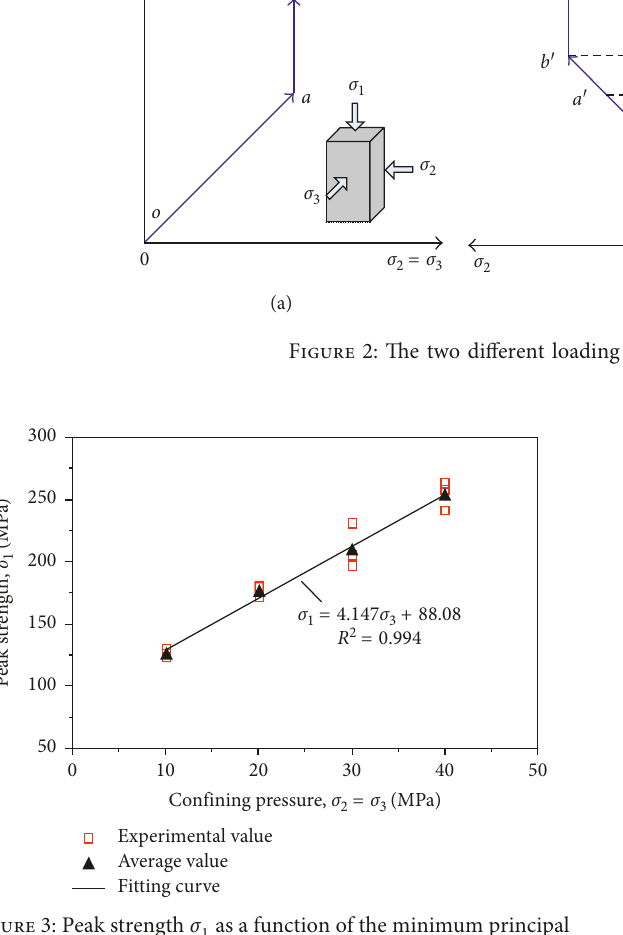
Figure 3: Peak strength σ 1 as a function of the minimum principal stress σ 3 under conventional triaxial stress and the best-fit linear function strength criterion (Mohr–Coulomb) for sandstone specimens.